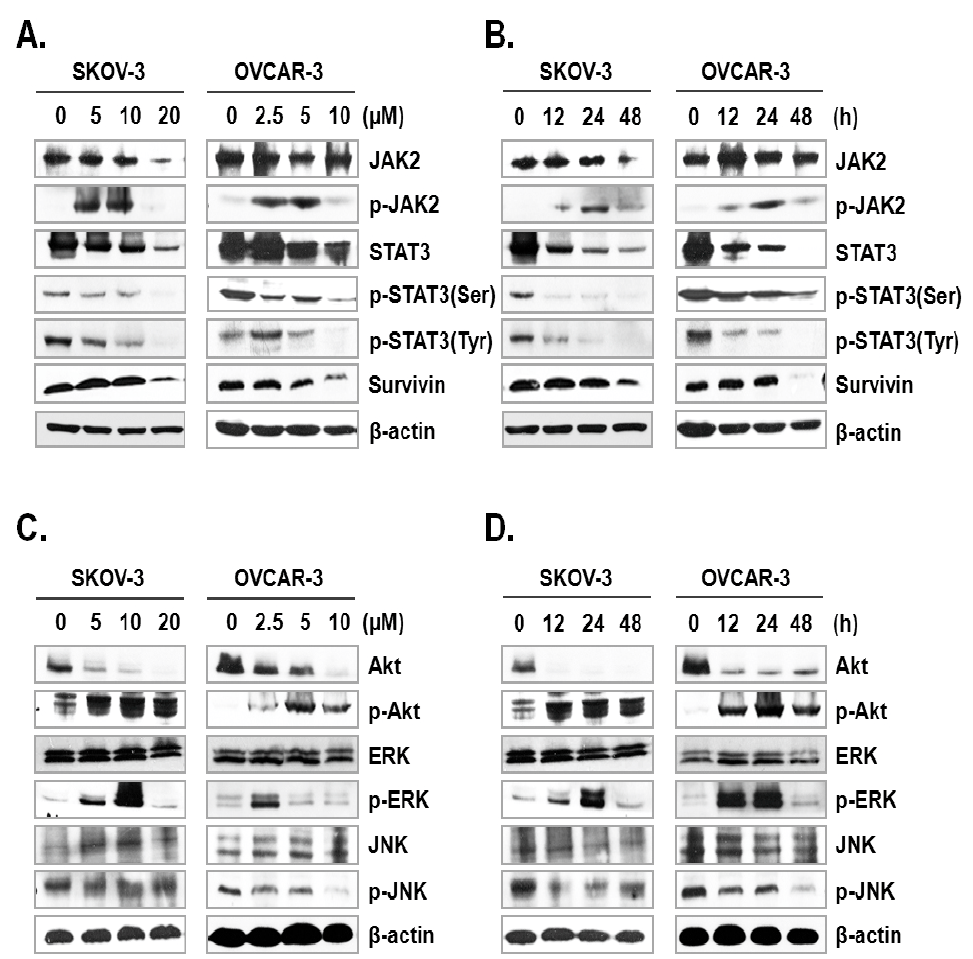
Figure 4. ILL-induced inhibition of STAT3-mediated signaling and gene expression. ( A , B ) SKOV-3 and OVCAR-3 cells were treated with the indicated ILL concentrations for the indicated times. Cellular levels of p-STAT3 (Ser), p-STAT3 (Tyr), and STAT3 were determined by immunoblot analysis. ( C , D ) Expression levels and phosphorylation status of various stress-activated kinases detected by immunoblot